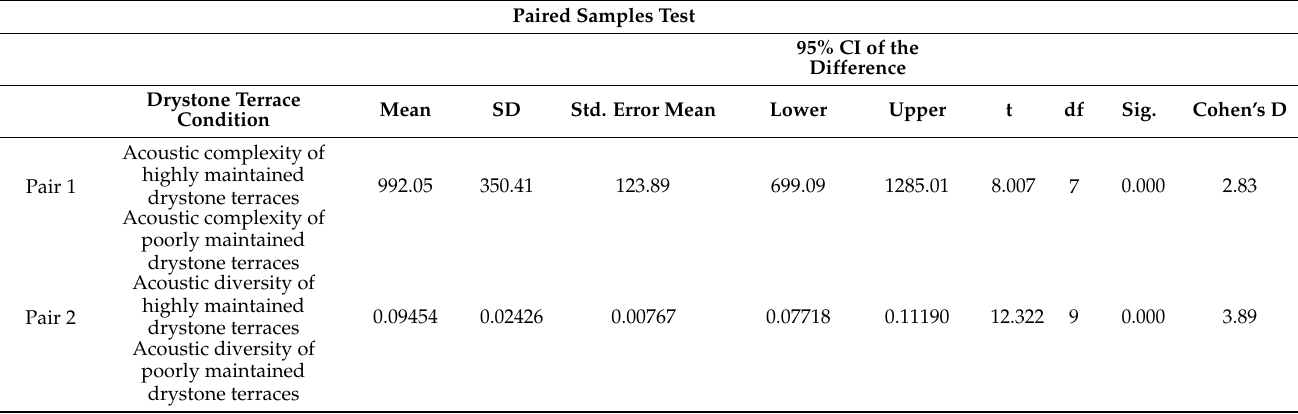
Table 2. Paired Samples Test results and effect size